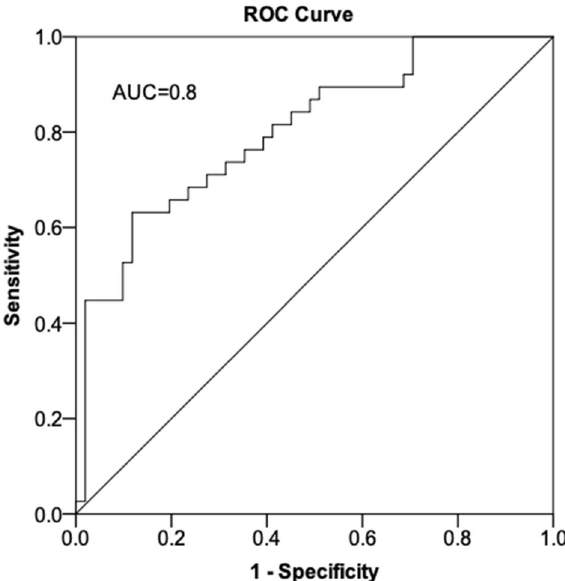
Figure 3. Receiver operating characteristic curve for predictors of Gulf War Illness. The curve is for a model using age, diagnosis of post-traumatic stress disorder (PTSD), overall retinal nerve fiber layer (RNFL) thickness, and cup-to-disc ratio as predictors. Forward stepwise binary logistic regression was used to develop the model. Receiver operating characteristic was used to test the ability of the model to predict a GWI diagnosis (yes/no). ROC = receiver operating characteristic. Figure was created using SPSS (version 24.0, https:// www. ibm. com/ produ cts/ spss- stati